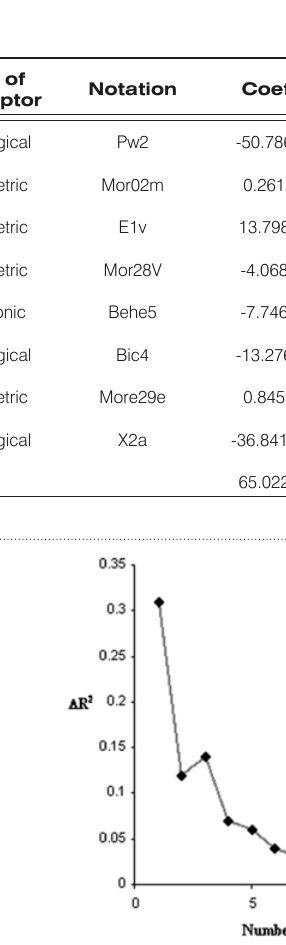
Figure 3. The plot of Δ R 2 versus the number of descriptors